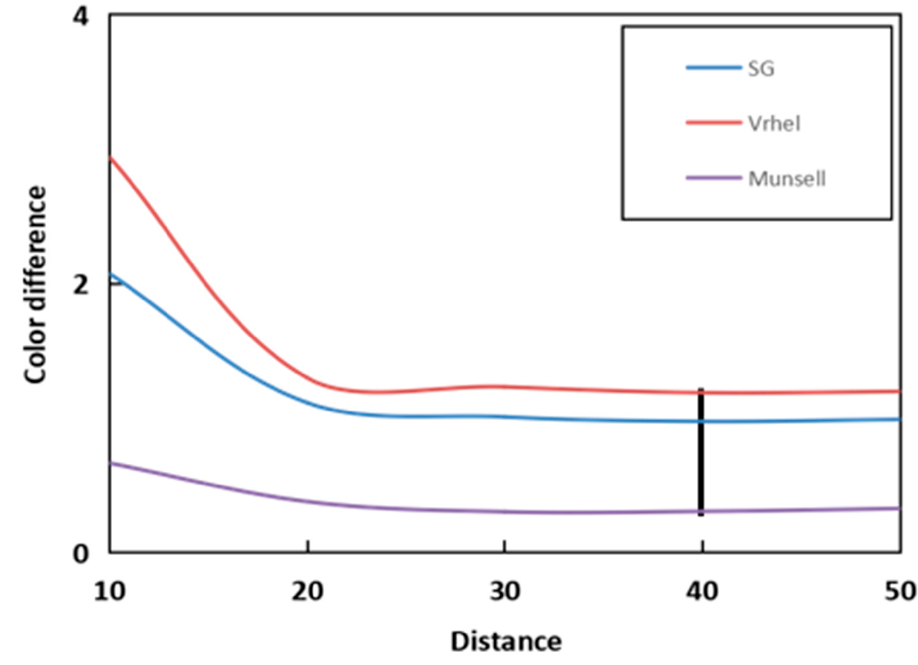
Figure 5. Relationship between the distance and averaged mean color differences.